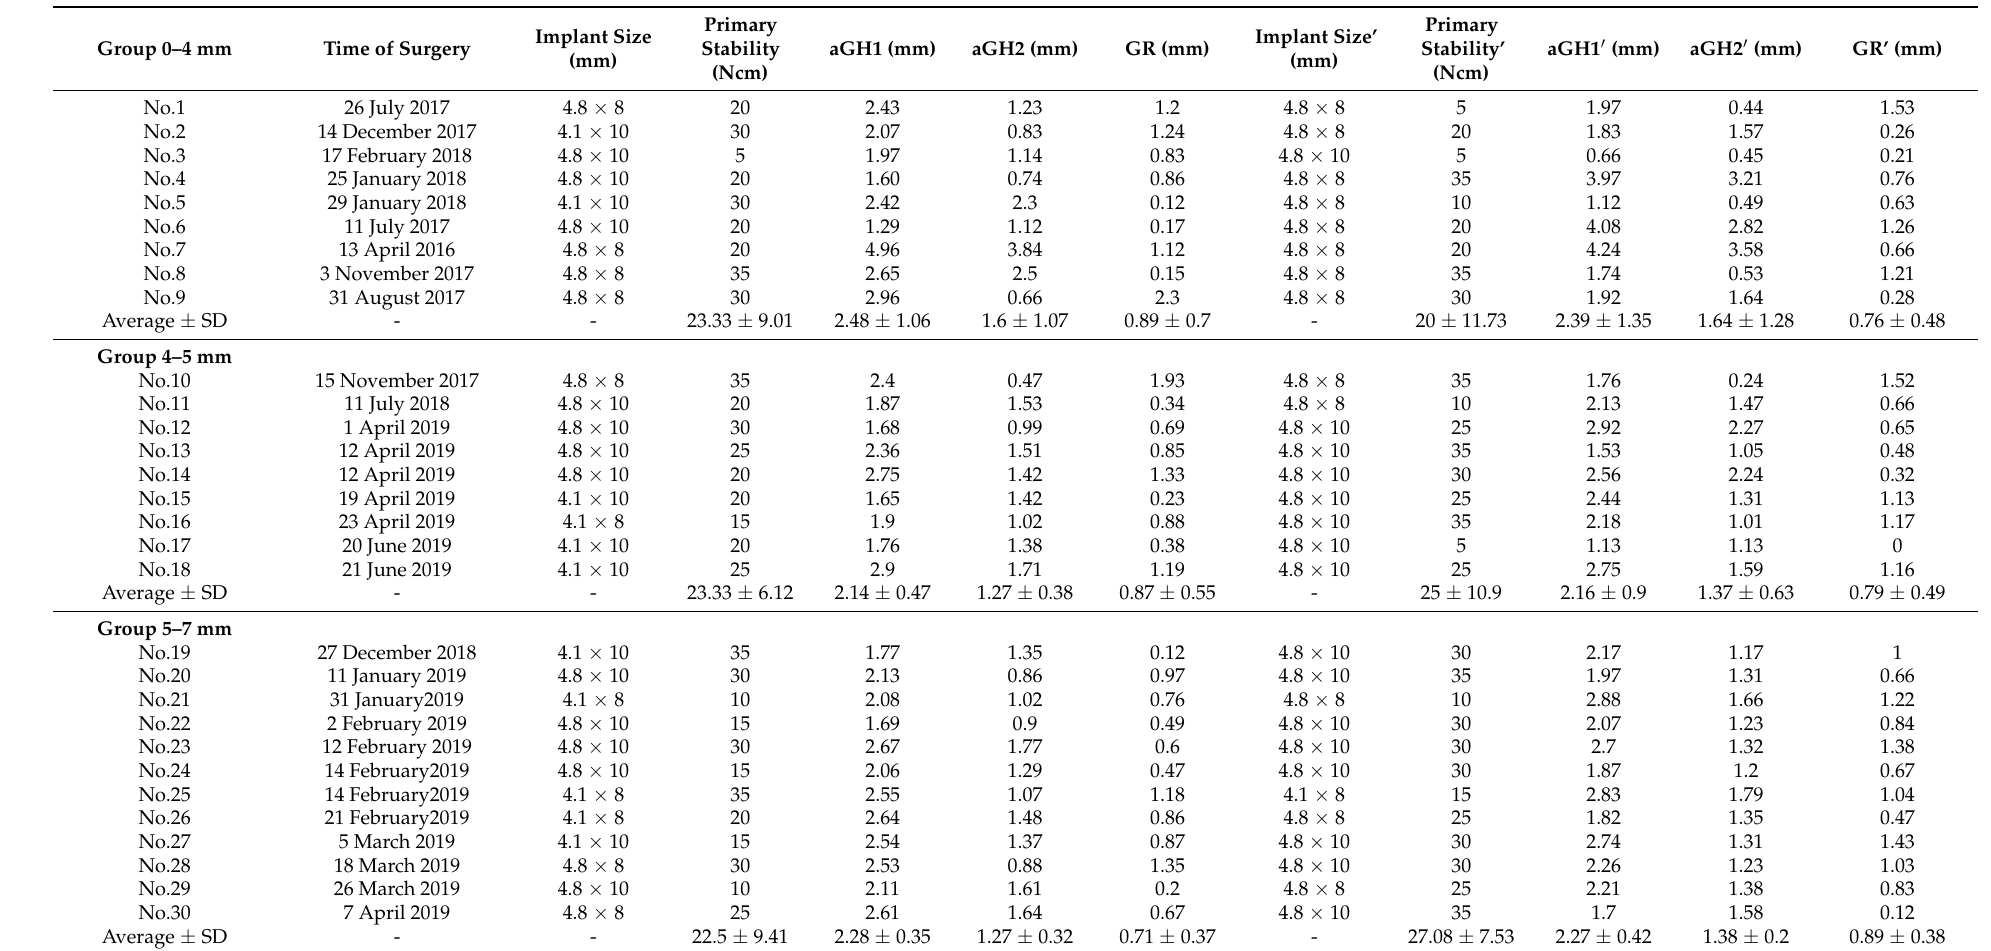
Table 3. Surgery documents and CBCT measurement of implant